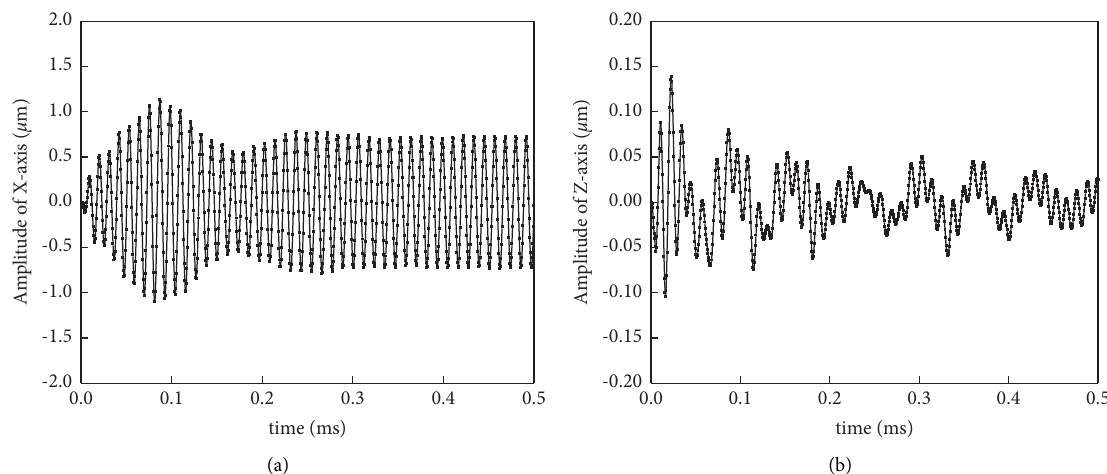
Figure 10: Variation of the amplitude of a particle on driving foot surface with time. (a) x -axis. (b) z -axis.